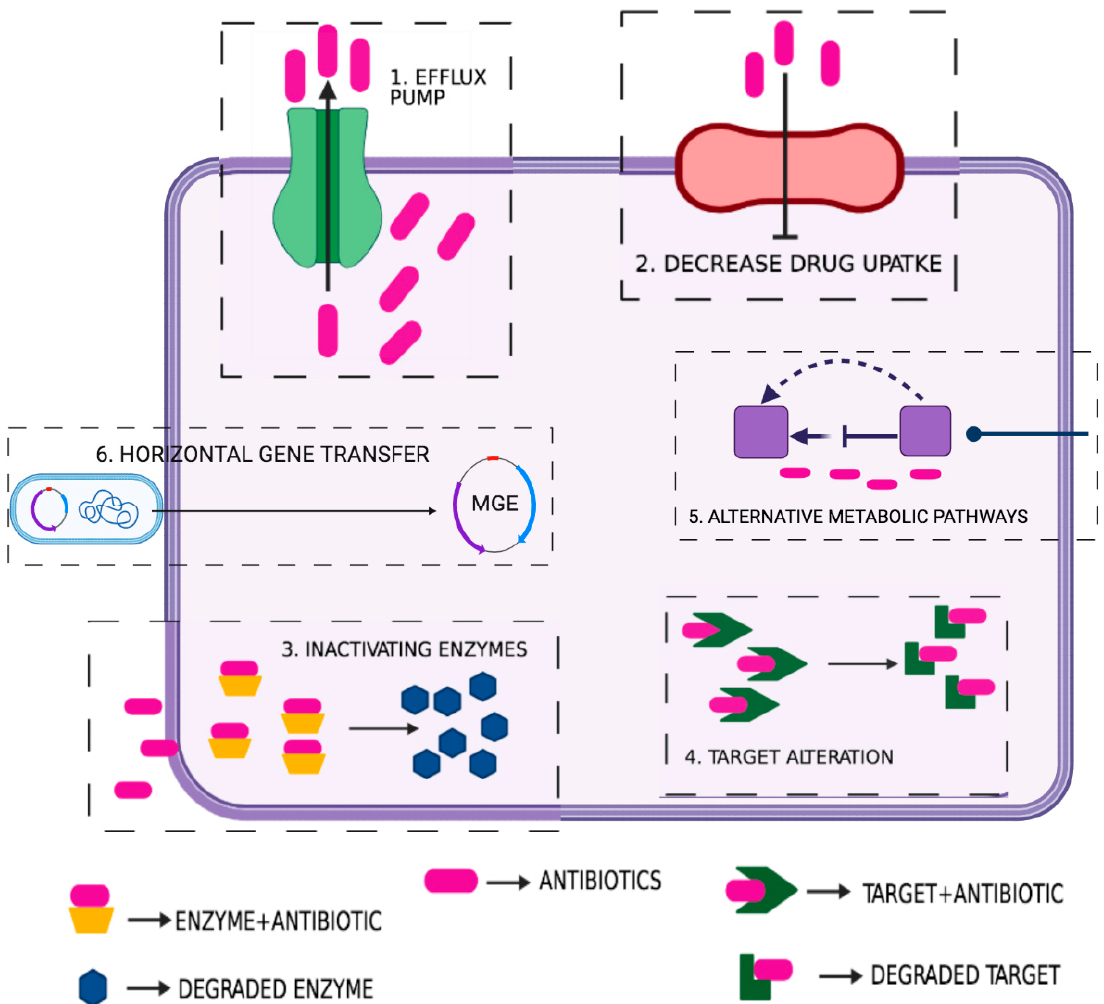
Figure 2. Diagrammatic illustration of few possible mechanisms in bacteria contributing towards various antibiotic resistance such as: 1. Active efflux of various antibiotic via pumps; 2. Prevention or decrease drug uptake by the cell; 3. Antibiotic inactivating enzymes; 4. Modification or alteration of targets; 5. Use of alternative or bypass metabolic pathways; 6. Acquired antibiotic resistance mechanism (HGT).